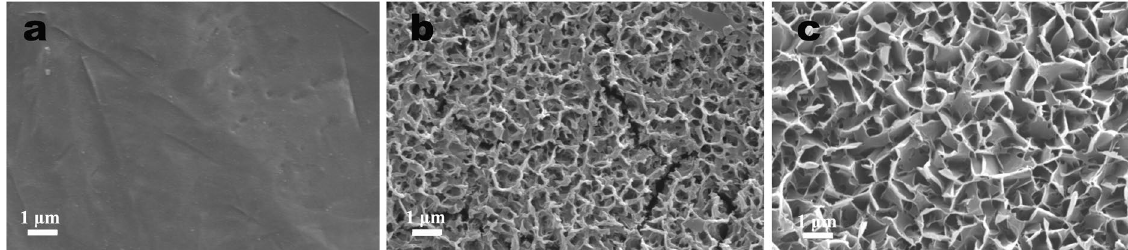
Figure 1. SEM images of surface morphologies for Ti plates: ( a ) pure Ti surface, ( b ) treated at 100 °C for 4 h in 10 M NaOH solution under atmospheric pressure and ( c ) treated at 120 °C for 240 mins in 10 M NaOH solution under 0.15 MPa.